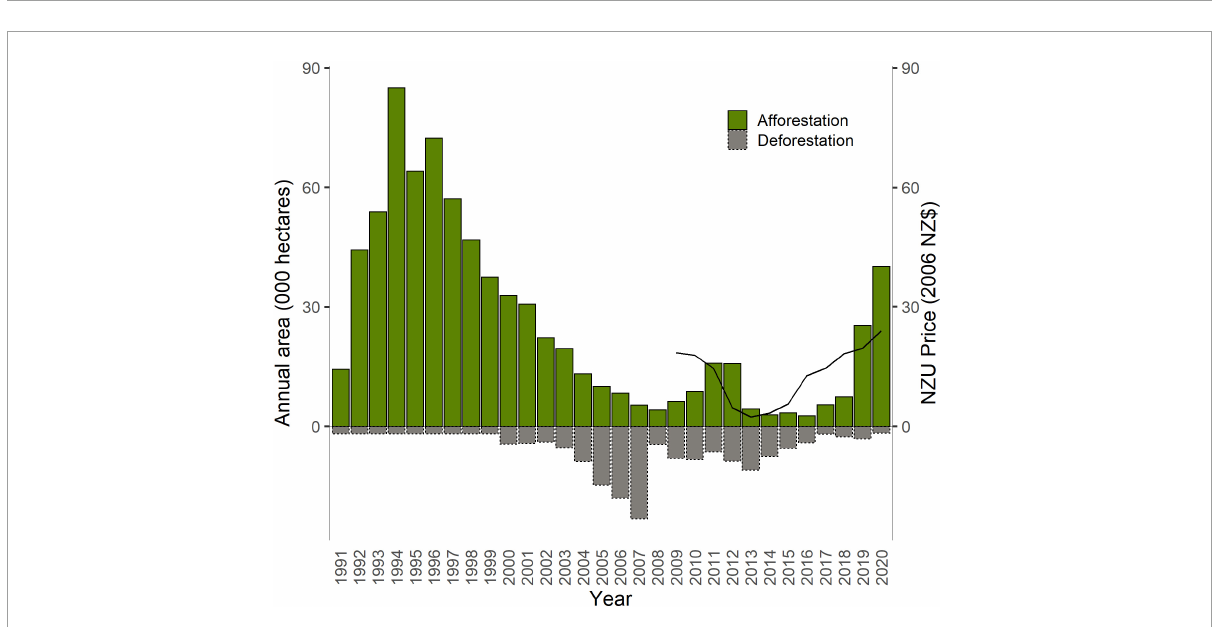
FIGURE10 Annual area of net afforestation of post-1989 forest land and deforestation of pre-1990 forest land. The NZU price is shown by the black line, beginning once the NZ ETS was implemented. Data from Jarden (2022) and MfE